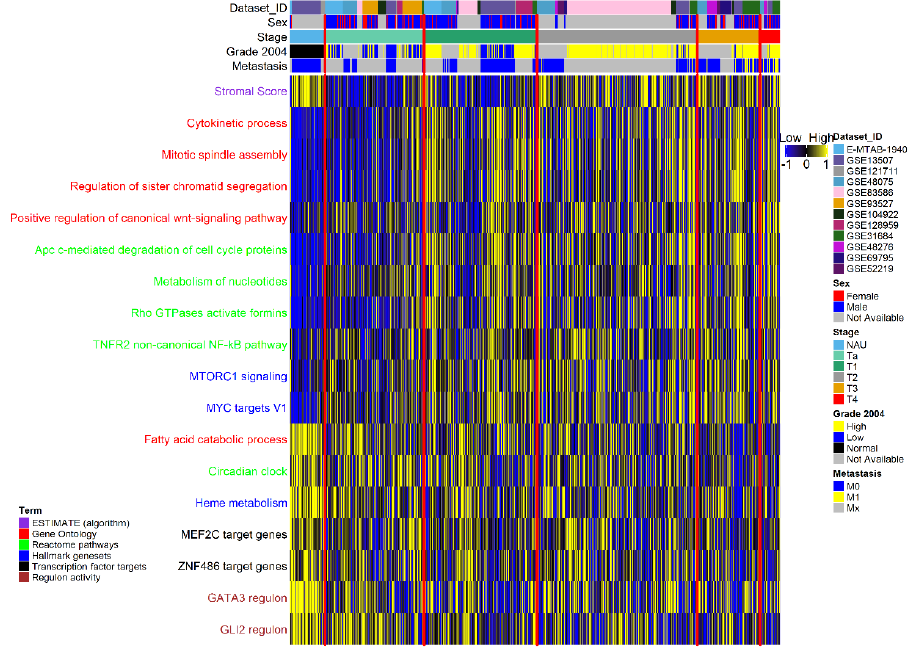
Figure 2. Excerpt of the pathways showing a monotonal increase or decline in their activation scores with higher stage. Pathway activation scores were z-scaled across samples for visualization. Pathways are colored based on their database of origin. The top side of the heatmap presents dataset and clinical information. Samples (columns) are ordered based on the stage variable; from left to right: non-malignant adjacent urothelium (NAU), Ta, T1, T2, T3, and T4. Red lines indicate boundaries between adjacent